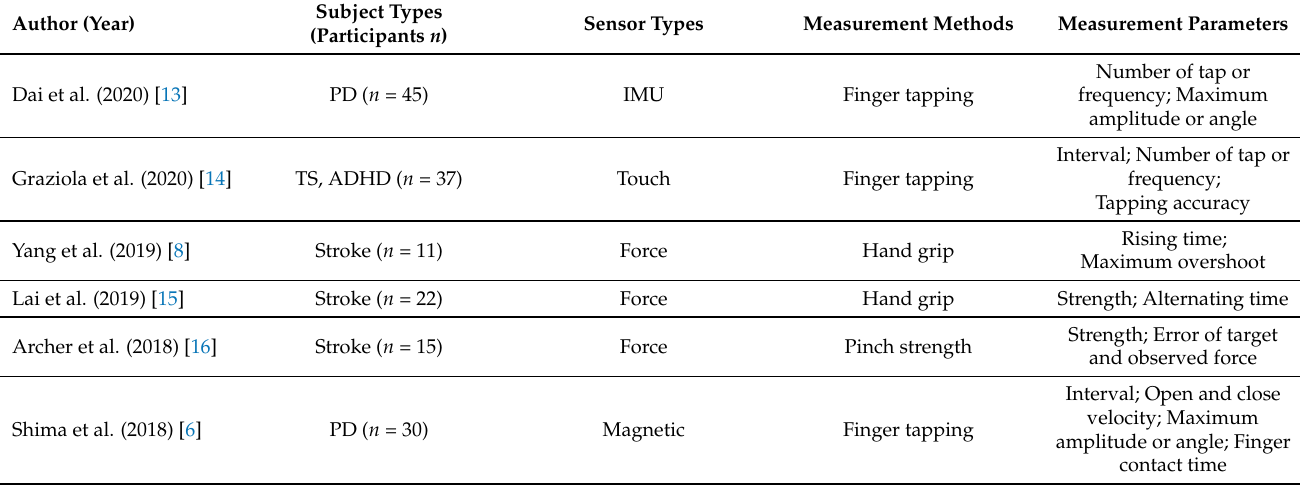
Table 2. Features of Literatures included in this